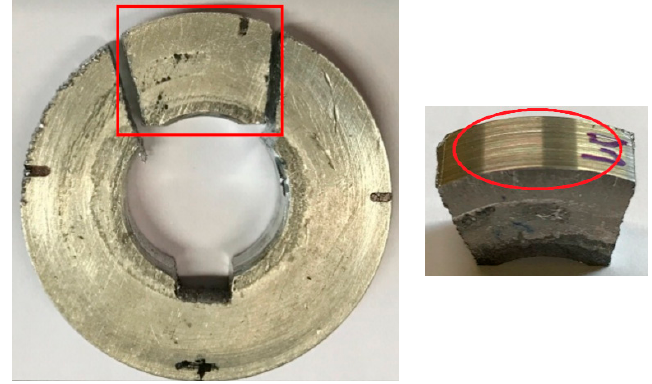
Figure 13. Cut disk and study zone highlighted in red.